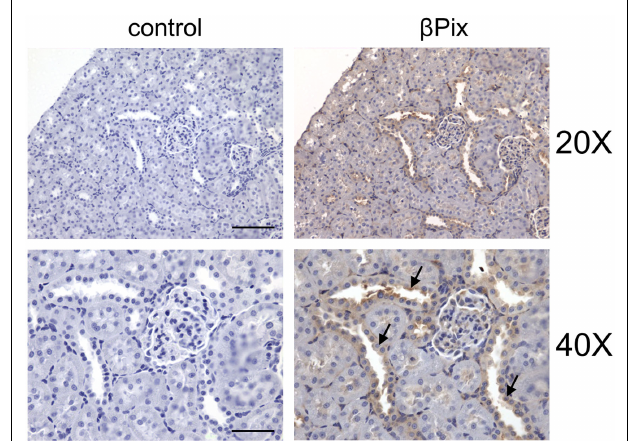
FIGURE 6 | β Pix expression in rat kidney tissue. Representative immunohistochemical staining for β Pix detection (right) in kidney cortical sections of Sprague-Dawley rat. Original magnifications, × 20 (upper; scale bar: 100 μ m) and × 40 (lower; scale bar: 50 μ m; cortical collecting ducts (CCD) are shown by arrows. Reproduced from Pavlov et al., 2010 with